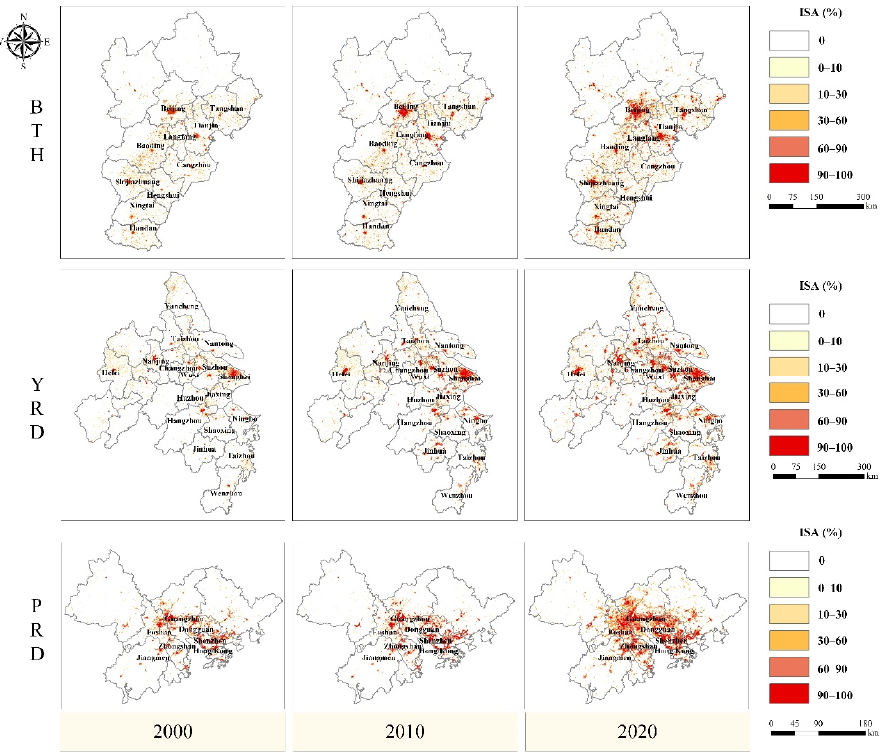
Figure 3. ISA map of each urban agglomeration. BTH, Beijing–Tianjin–Hebei; PRD, Pearl River Delta; YRD, Yangtze River Delta. Table 4. Landscape metric values of built-up land use for each urban